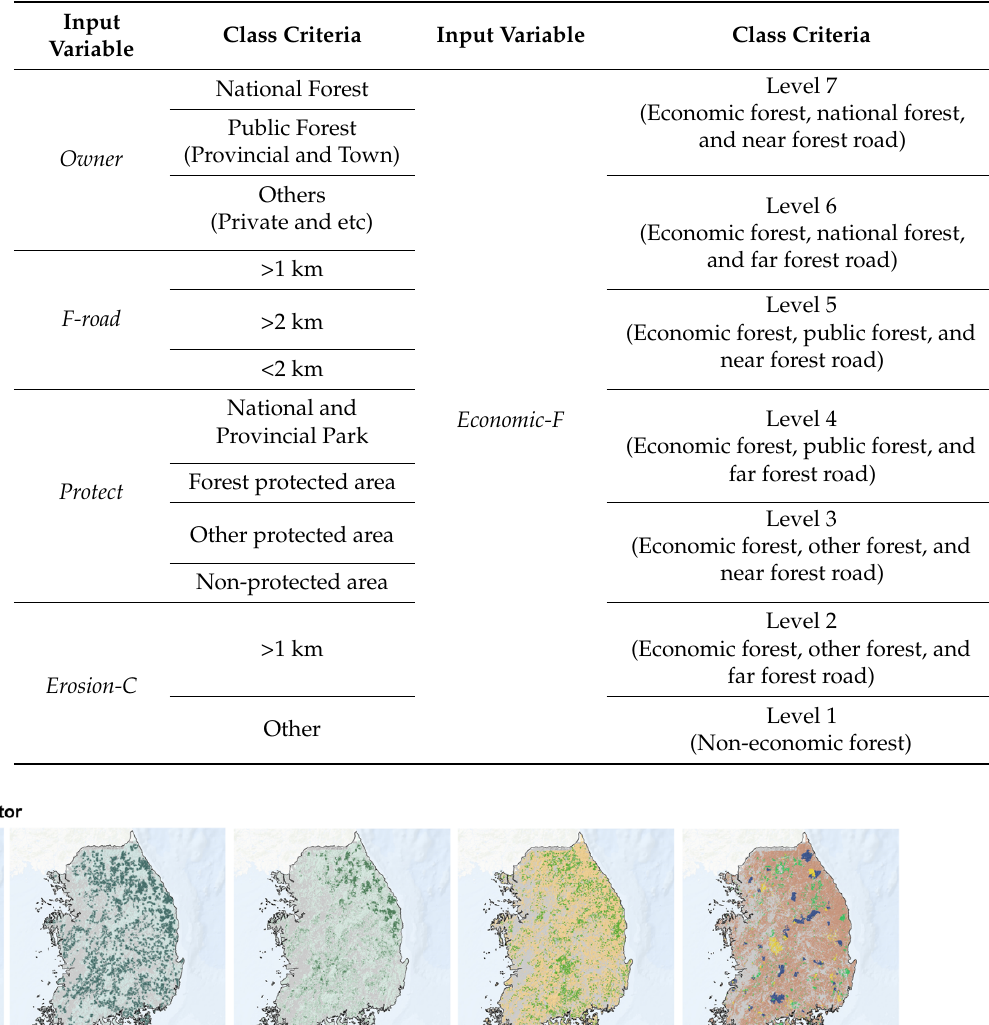
Table 2. Class criteria of forest-related adaptive indicators.